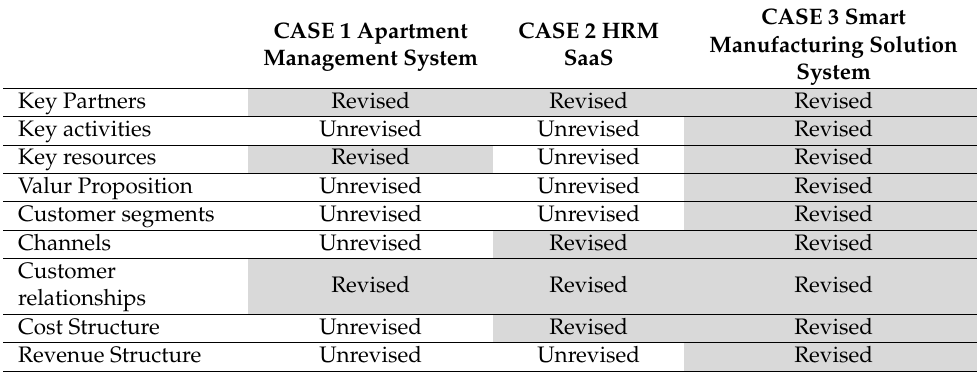
Table 4. Focus on business model